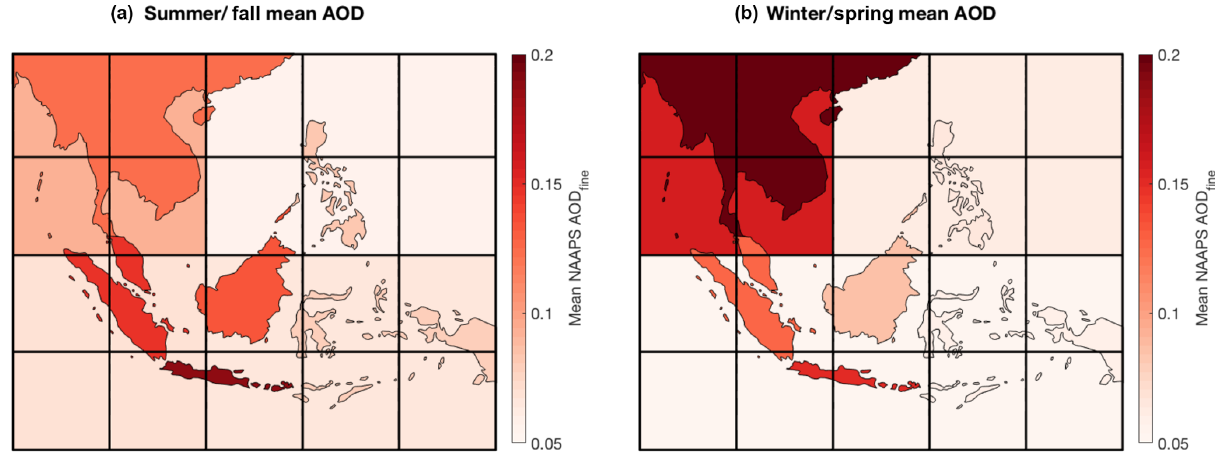
Figure 6. Geometric means of fine mode AOD from NAAPS for the SEA domain separated into boreal summer and fall (JJASON) on the left and winter and spring (DJFMAM) on the right. Note the means are also separated by land and ocean. Table 1. Lower fine mean AOD thresholds, median AOD, and upper AOD thresholds, shown for winter and summer for each of the six land regions and four ocean grids. Bolded numbers are the mean AOD. Thresholds were found by computing the geometric mean ( µ AOD ) and geometric standard deviation ( σ AOD ). The lower threshold is µ AOD ÷ σ AOD ; any AOD below this is considered clean . The upper threshold is µ AOD × σ AOD ; any AOD above this is polluted . Summer Summer Summer Winter Winter Winter 0.12